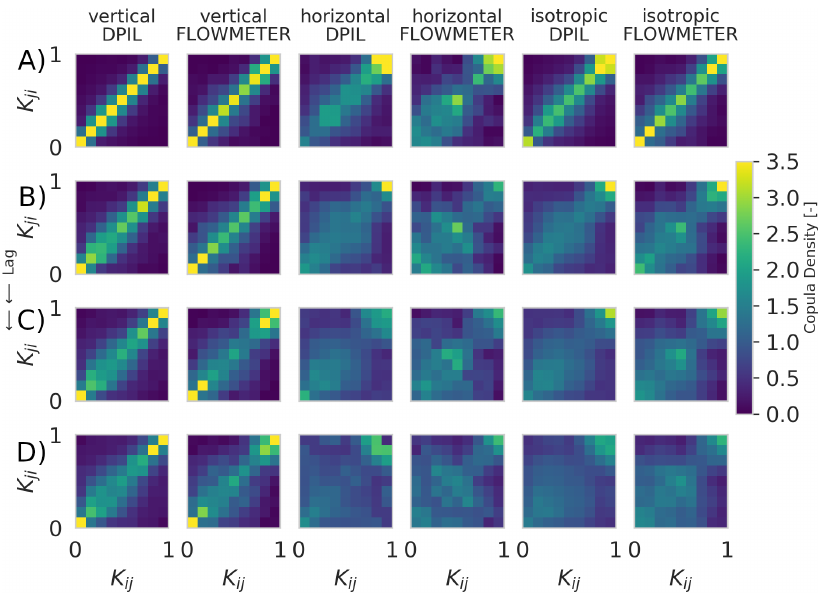
Figure 8. Empirical copula densities in the vertical direction (DPIL: 1st panel, flowmeter: 2nd panel), in the horizontal direction (DPIL: 3rd panel, flowmeter: 4th panel) and the isotropic case (DPIL: 5th panel, flowmeter: 6th panel). Distances from top to bottom are ( A ) 0.15, ( B ) 0.375, ( C ) 0.525, ( D ) 0.675 meter in the vertical direction and ( A ) 2.5, ( B ) 7.5, ( C ) 12.5, ( D ) 17.5 meter in the horizontal direction and the isotropic